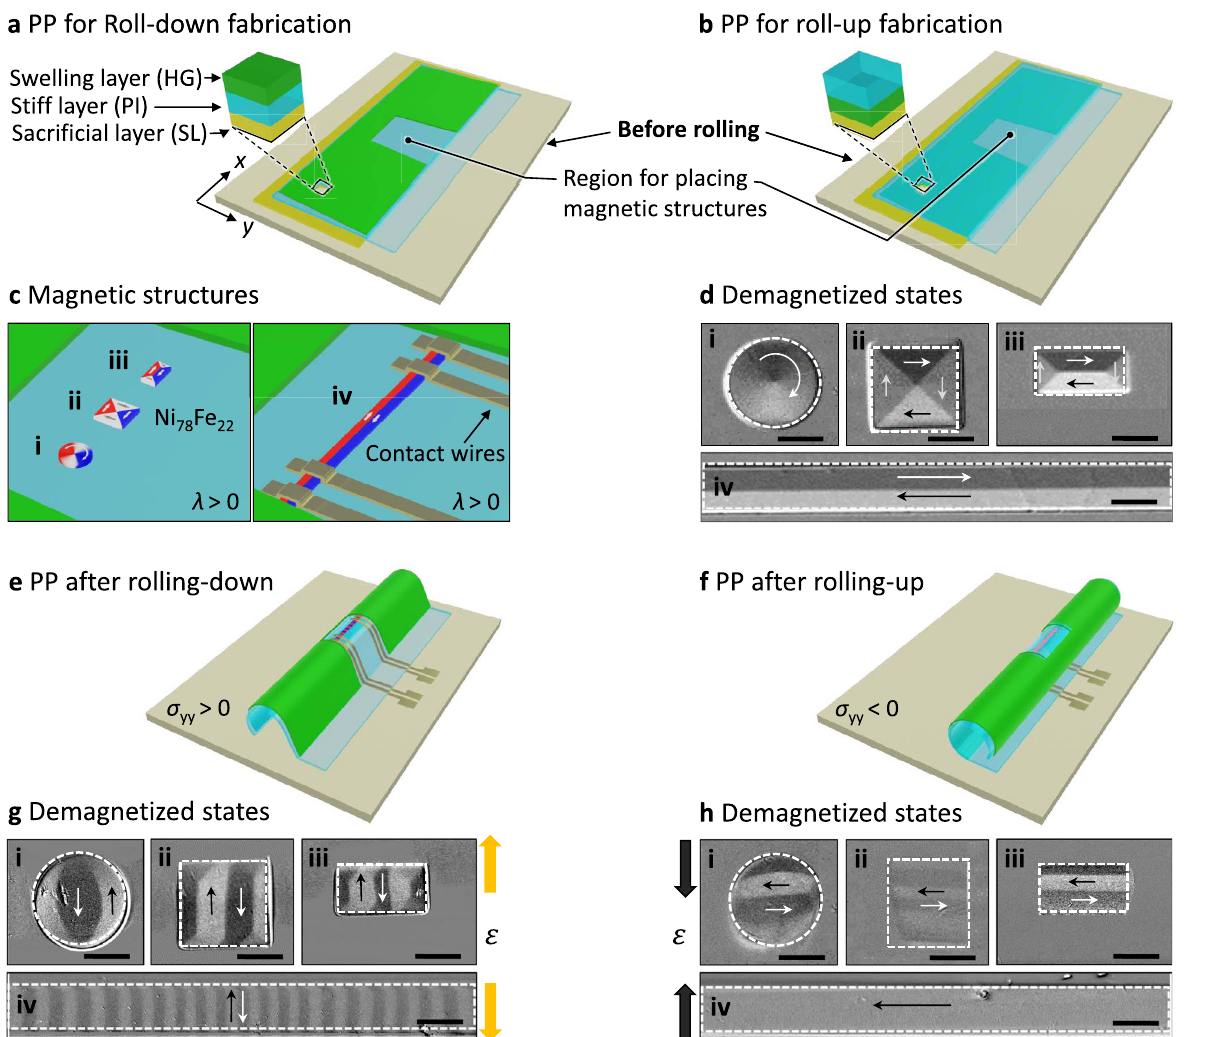
Fig. 2 Strain-induced changes in uniaxial magnetic anisotropy and therefore in magnetic domains upon rolling planar magnetic (Ni78Fe22, positive magnetostriction) structures. Polymeric platform (PP) before rolling for a rolled-down and b rolled-up fabrication. c Schematic images of magnetic domains in c - i disc, c - ii square, c - iii rectangle, and c - iv stripe structures in the planar state. d Kerr images of these four planar structures. Schematic image of the polymeric platform (with magnetic stripe and contact wires) after etching the sacri fi cial layer (SL) and e rolling down, and f rolling up. Kerr images of g rolled-down, and h rolled-up magnetic structures after ac-demagnetization in a fi eld transverse to the induced anisotropy axis. Scale bars in d , g , h are 15 µm. The black and white arrows in the domains indicate the magnetization direction. The yellow and black arrows next to the Kerr images show the tensile and compressive strain ( ε ) curvature-induced modi fi cation in the rolled-down structures using three factors: (i) due to the even curvature of the rolled- down membrane, the resulting homogeneously induced aniso- tropy is independent of position and can thus be observed locally at any region on the dome of the rolled-structure accessible to magnetic microscopy; (ii) domain observation is linked to a global electronic signal by simultaneously measuring magnetoresistance; (iii) micromagnetic simulations con fi rm the observed correlation between local (microscopic) and global (AMR) behavior as a general feature of an elongated AMR structure and connect the AMR signal quantitatively with the induced anisotropy. Figure 3a displays the magnetic domain evolution of an AMR stripe in the rolled-down state as a function of an axial fi eld together with the simultaneously measured AMR signal (the detailed magnetization reversal as a function of fi eld transverse to the stripe for the rolled-down stripe and as a function of fi eld along the stripe for a rolled-up stripe is reported in Supplementary Figs. 2, 3,